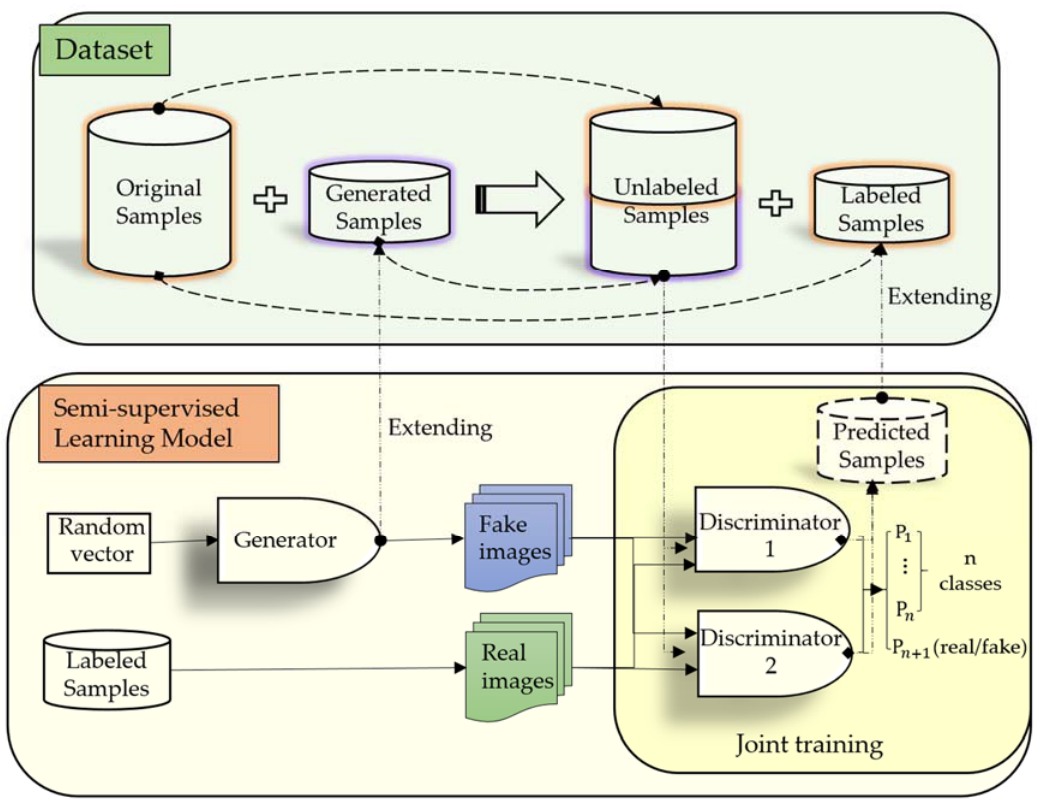
Figure 1. Framework of the deep convolutional generative adversarial networks (DCGANs) ‐ based semi ‐ supervised learning method.